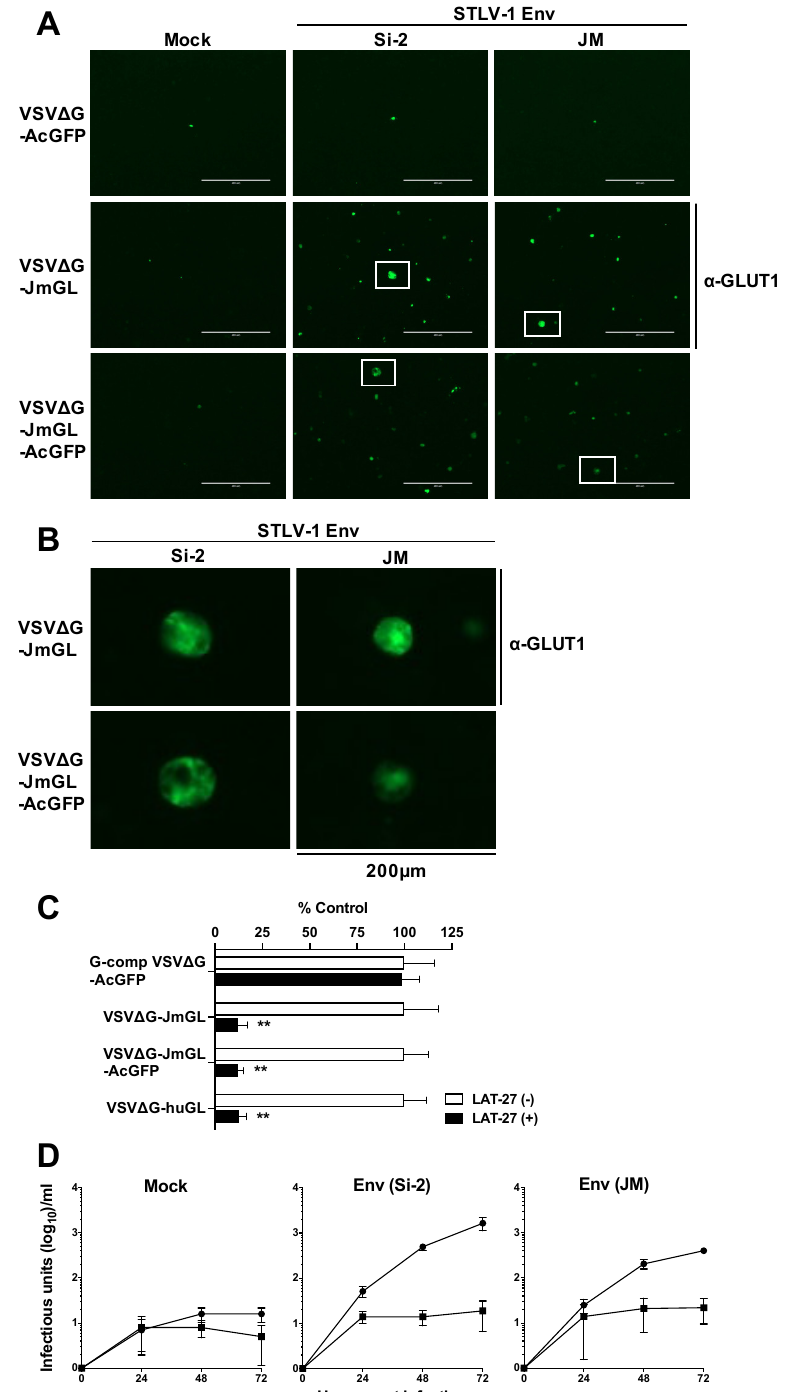
Figure 3. Functional assessment of infectivity and specificity of rVSVs. ( A , B ) STLV-1 Env-dependent infectivity of rVSVs was evaluated. BHK-21 cells were initially mock-transfected (empty vector) or transfected with expression plasmids for STLV-1 Env derived from Si-2 cells or from STLV-1-infected JM PBMCs. After 24 h, transfected BHK-21 cells were infected with non-G-complemented rVSVs (0.25 mL each). After 3 days of culture, the cells were fixed. Subsequently, VSVΔG-JmGL-infected cells were stained with anti-GLUT1-specific MAb to detect rVSV-infected cells. On the other hand, VSVΔG-JmGL-AcGFP- or VSVΔG-AcGFP-infected cells were detected by GFP expression. Representative results from each group of rVSV-infected BHK-21 cells are shown in panel A. Areas enclosed with squares are enlarged in panel B. Syncytia with enlarged cell size in VSVΔG-JmGL- or VSVΔG-JmGL-AcGFP-infected cells are shown in panel B. Scale bars in panels A and B represent